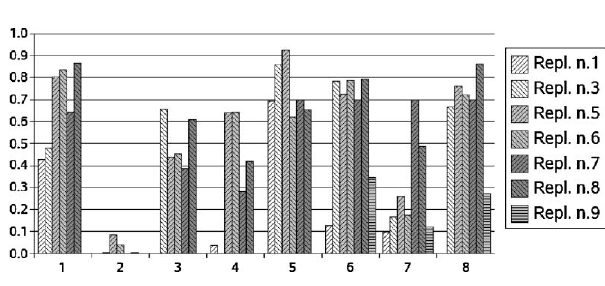
Figure 9. Performances of the evolved robots of the seven best replica- tions of the experiment observed by testing the robots with the eight objects shown in Figure